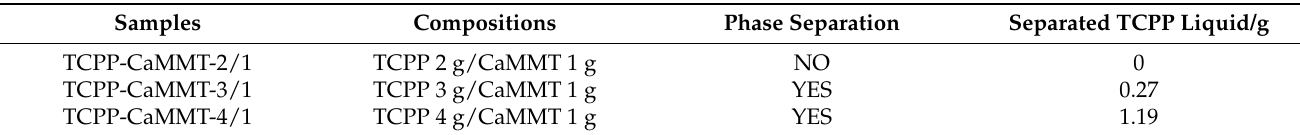
Table 3. Phase separation of TCPP-CaMMT gel with different TCPP/CaMMT ratios.